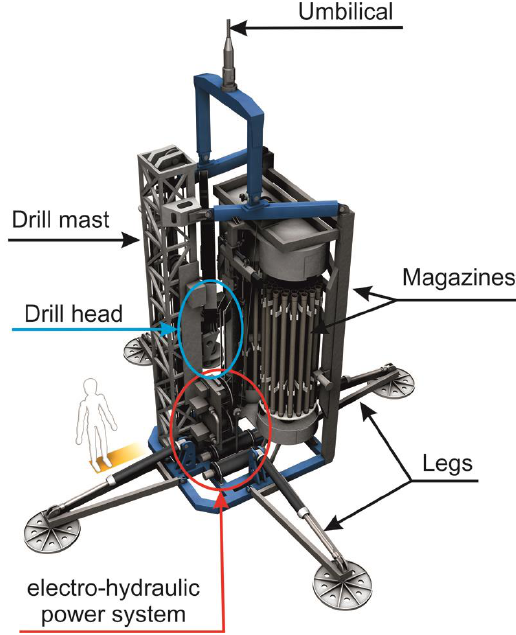
Fig. 4. Schematic overview of the major components of the MeBo Figure 4. Schematic overview of the major components of the MeBo. 3 (drawing: dibi Multimedia).